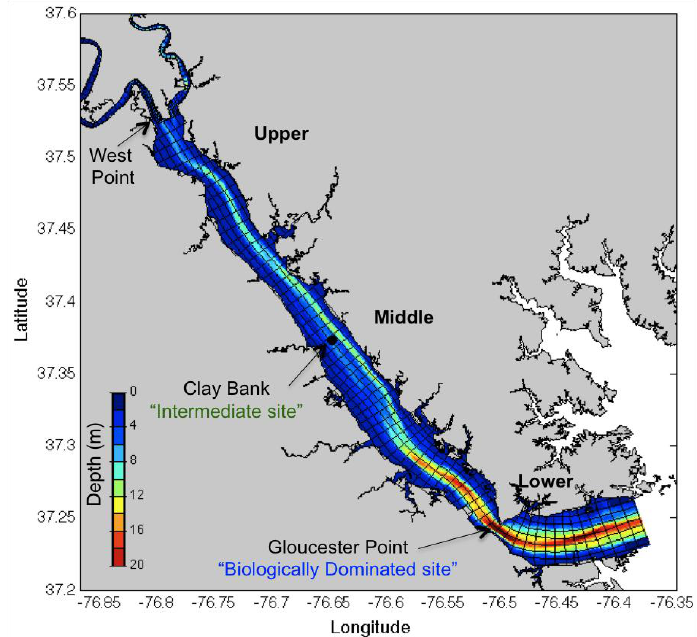
Figure 3. The York River estuary cohesive bed ROMS model grid used in in this study had 92 across channel cells and 334 along channel grid cells. Each square in the figure represents twenty-five model grid cells. This paper focuses on model results from the area around the Intermediate site (Clay Bank, VA, USA), which is marked with a black